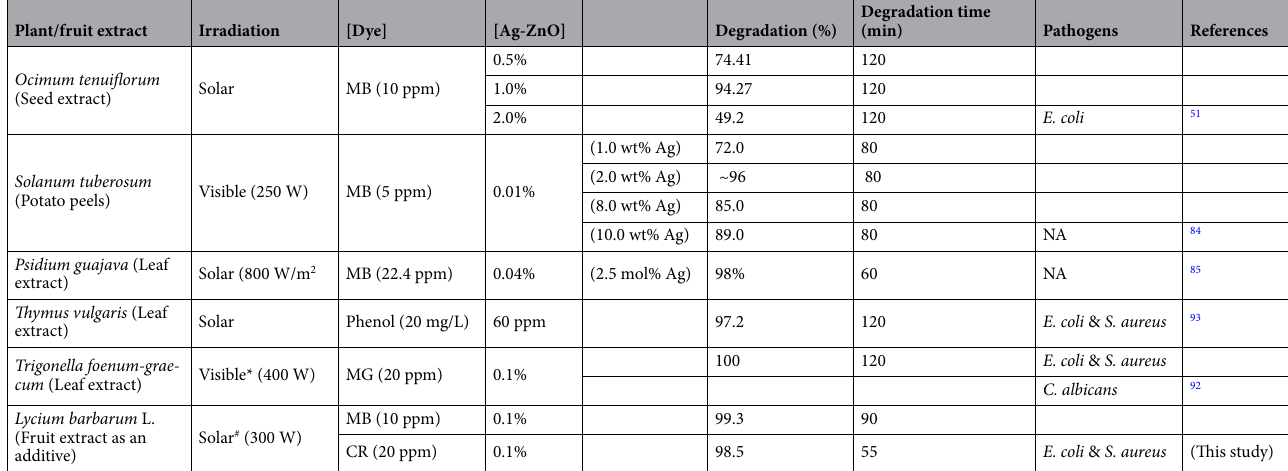
Table 1. List of Ag/ZnO NCs synthesized using plant/fruit extracts and their photocatalytic degradation of dyes and antibacterial activities. NA: not applicable, MB: methylene blue, MG: malachite green; *Hg lamp (λ > 420 nm); # simulated solar lamp.